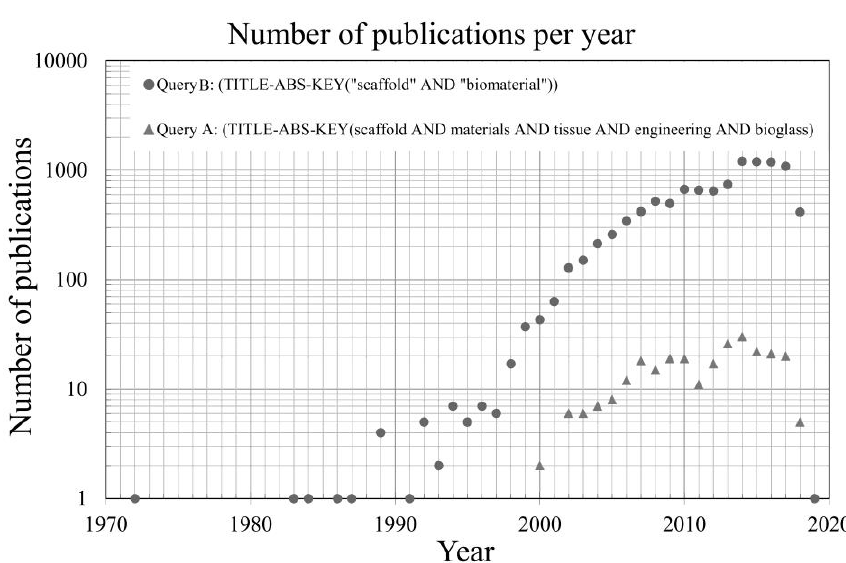
Figure 3. Number of publications of queries A and B in the timeline window between 1970 – 2020 (results obtained at the moment of the query search results); the Y-axis (number of publications) is presented in logarithmic scale.